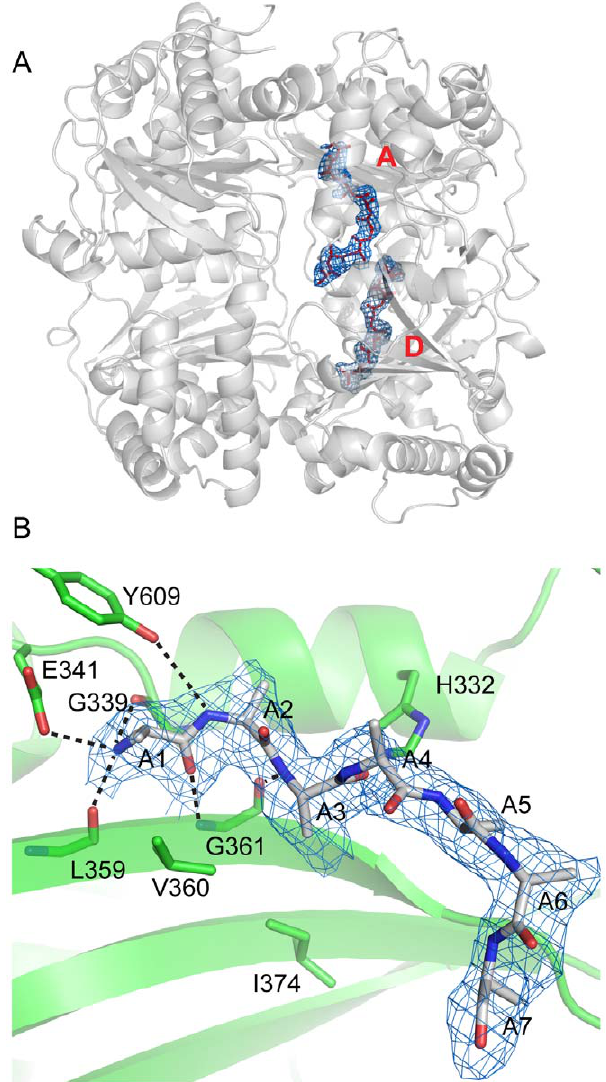
Figure 1. The rIDE-E111F crystal structure. (A) Overview of the structure. A ribbons representation of the enzyme is shown together with polyalanine ligands (red sticks) built into difference density (Fo-Fc, blue mesh, 2.0 sigma contour) at the active (A) and distal (D) sites. Difference density was produced with phases from a refined model of the enzyme prior to adding peptide models and so is not biased by the peptide models. (B) Interaction of bound peptide with the domain 2 distal site of rIDE-E111F. The polyalanine peptide ligand is shown (residues 1–4 of the seven residues in the model) in a stick representation with difference density calculated as described above (blue mesh, 2.0 sigma contour). Likely hydrogen bonds to the peptide backbone are indicated by dashed